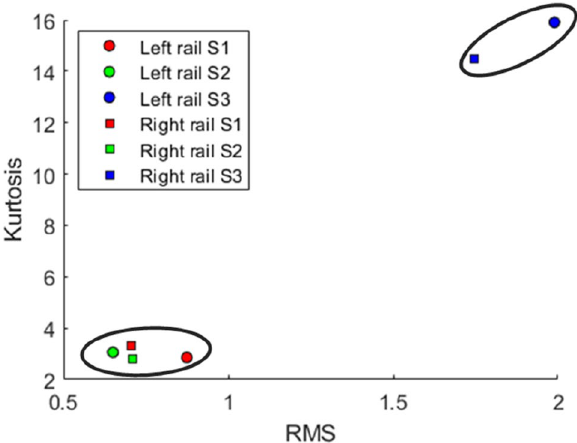
Figure 3. Application of distance-based clustering at the pre-processing